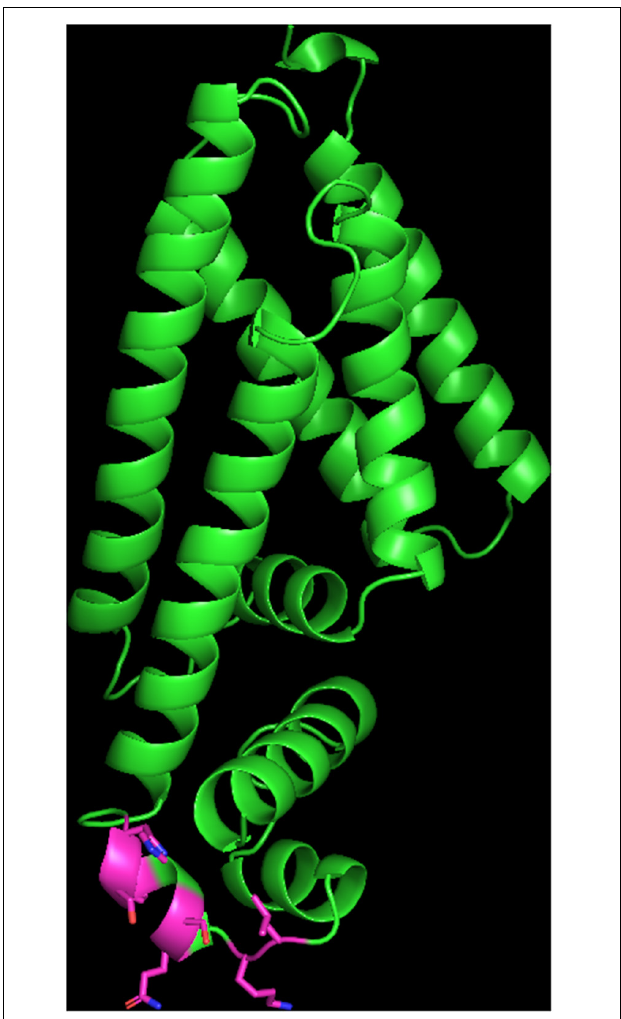
FIGURE 1 | Structure of the FepR protein. The carbon of the side chain of the mutated residues inside the HTH domain are shown in pink. Oxygen atoms are shown in red and nitrogen in blue. Hydrogen atoms are